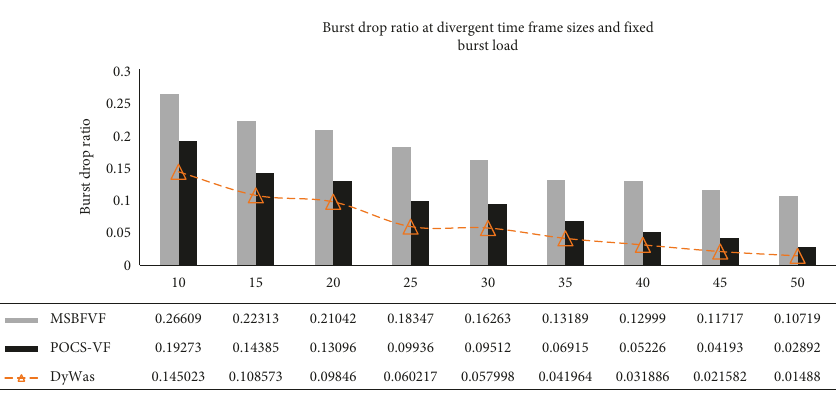
Figure 1: Ratio of burst drop to divergent burst load for a fixed timeframe of 35 μ s .